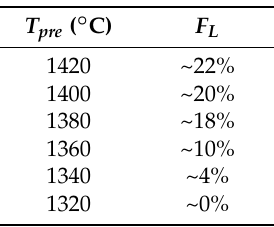
Table 2. The corresponding liquid fraction ( F L ) versus T pre relationship according to the Meng et al. study [4].